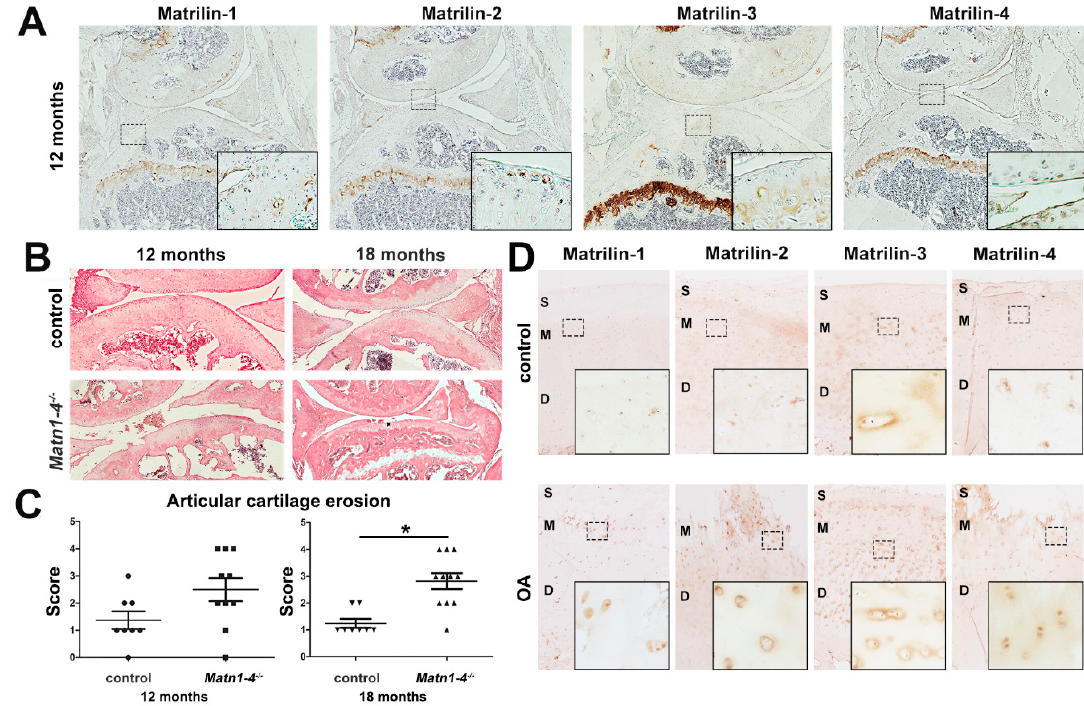
Figure 7. Matn1-4 − / − mice develop age-associated osteoarthritis. ( A ) Immunohistochemistry of knee joints demonstrates the moderate expression of matrilins in the articular cartilage of wild-type mice at 12 months of age. All matrilins have strong expression in the growth plate cartilage. Original magnifications: × 5 for overview pictures and x 20 for inserts. ( B ) HE staining of the knee joint at 12 and 18 months old control and Matn1-4 − / − mice. Original magnification × 10. ( C ) Histological grading for cartilage degradation indicates higher incidence and severity of osteoarthritic-like erosion in Matn1-4 − / − mice compared to age-matched controls (* p < 0.05). ( D ) Analyzing the expression of matrilins in healthy (control) and osteoarthritic human knee articular cartilage derived from the tibia by immunohistochemistry demonstrates upregulation of all matrilins in the OA tissue. The depicted zones: S-superficial; M-middle and D-deep. Original magnifications: × 5 for overview pictures and × 20 for